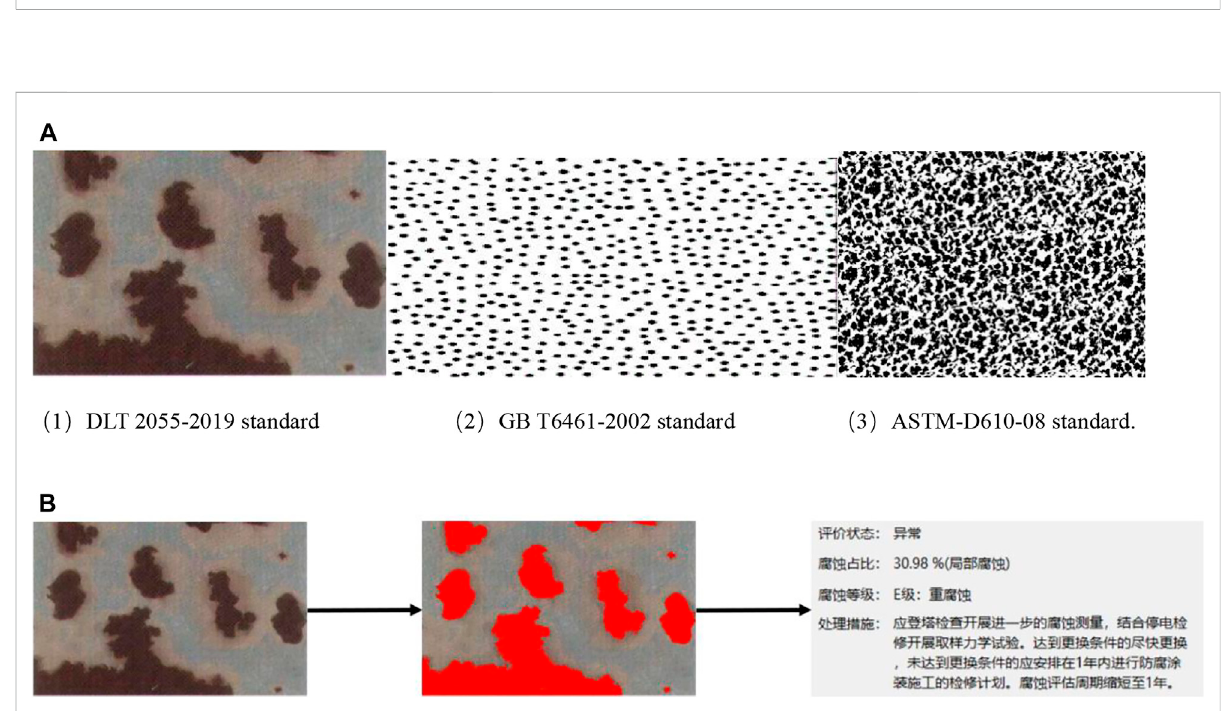
FIGURE 4 Example diagram and result diagram. (A) Example images in each major standard and (B) standard corrosion spectrum recognition